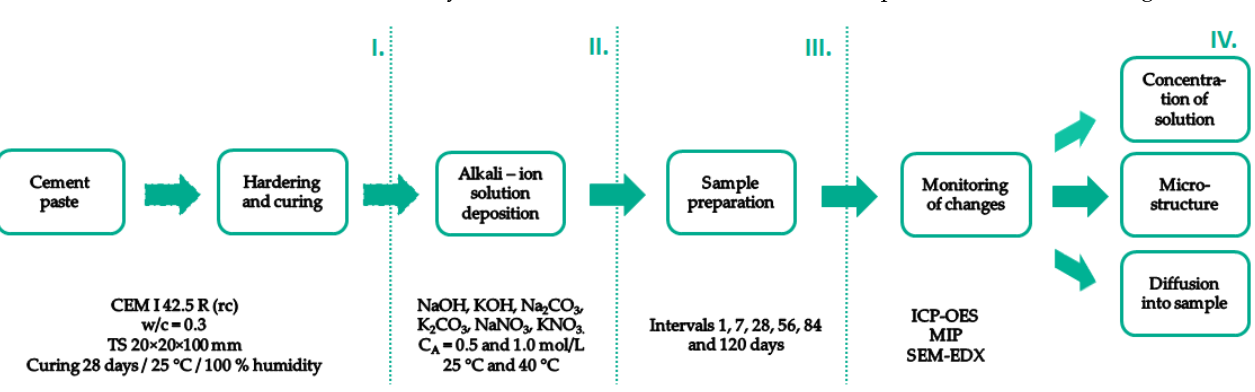
Figure 1. Schematic workflow of the experiment.